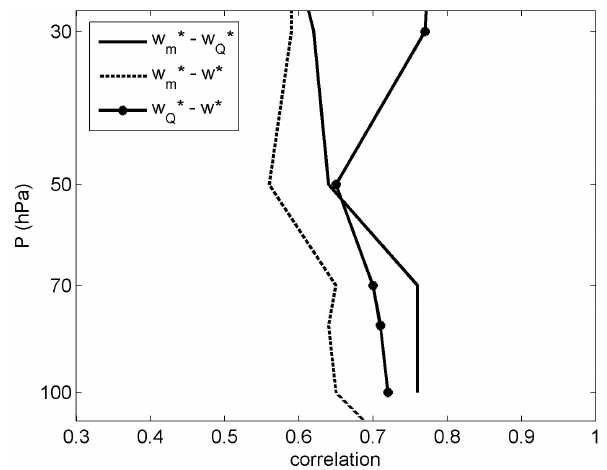
Fig. 3. Time series and mean seasonal cycles of the three upwelling estimates averaged over 18 ◦ N–S at 70, 80 and 100hPa (top to bottom panels). Green: residual circulation ( w ∗ ), blue: momentum balance estimate ( w ∗ m ), and red: thermodynamic estimate ( w ∗ means are applied to the time series. The annual cycles are calculated as monthly means over 2005–2010 (mms − 1 ).